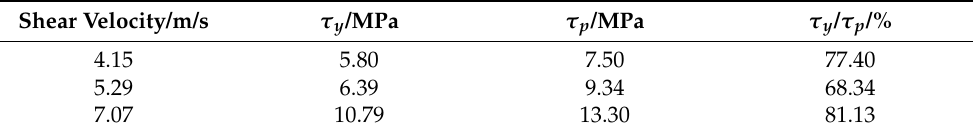
Table 4. Yield stress under high velocity impact.